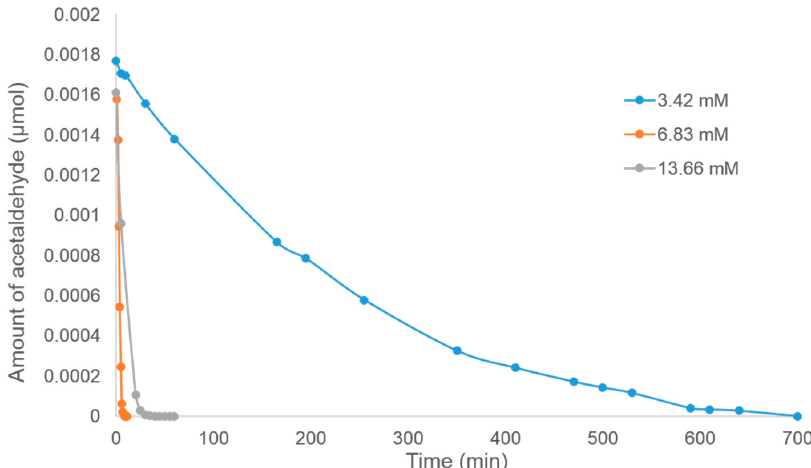
Figure 5. Photocatalytic decomposition of acetaldehyde by using TiO 2 on stainless steel prepared by Spray-ILGAR technique using different concentrations of TiO 2 precursor (3.42, 6.83 and 13.66 mM), heated at 460 °C and spraying time of 12 min.